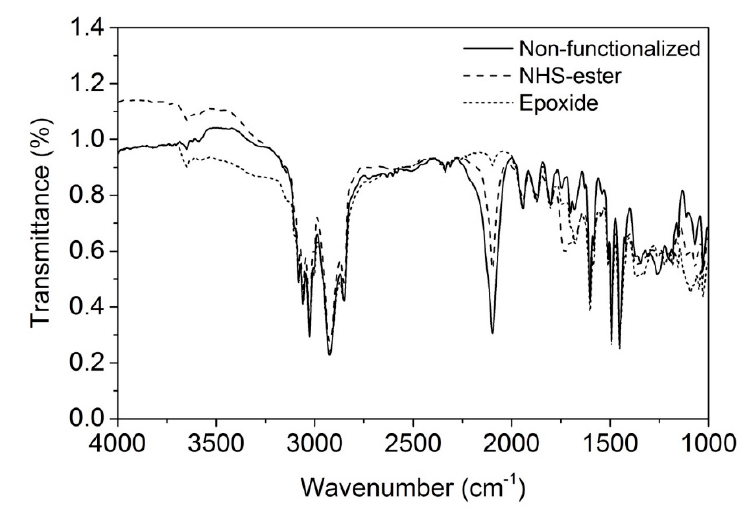
Figure 5. Nitrogen adsorption—desorption cycle giving a TYPE-II isotherm, which is characteristic for macroporous materials. The small hysteresis at higher relative pressures indicates capillary condensation. 3.4. Functionalization by Click-Chemistry & Protein Immobilization The macroporous materials were chemically modified by click-chemistry to introduce active sites, which are commonly used for protein immobilization on the polymer surface. In a first experiment, propargyl-dPEG1-NHS-ester was attached to the polymer surface which can readily be attacked by nucleophiles present in proteins (e.g., primary amines from lysine). Figure 6 shows the FT-IR spectra of the pristine azide-containing starting material and its characteristic asymmetric azide stretch at 2100 cm − 1 . This specific stretch disappears at full conversion, after the 1,3-dipolar